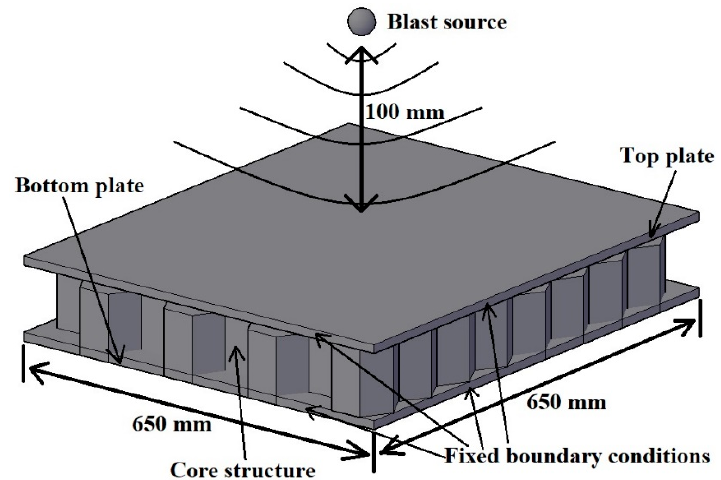
Figure 1. Schematic drawing of blast loading and boundary conditions.